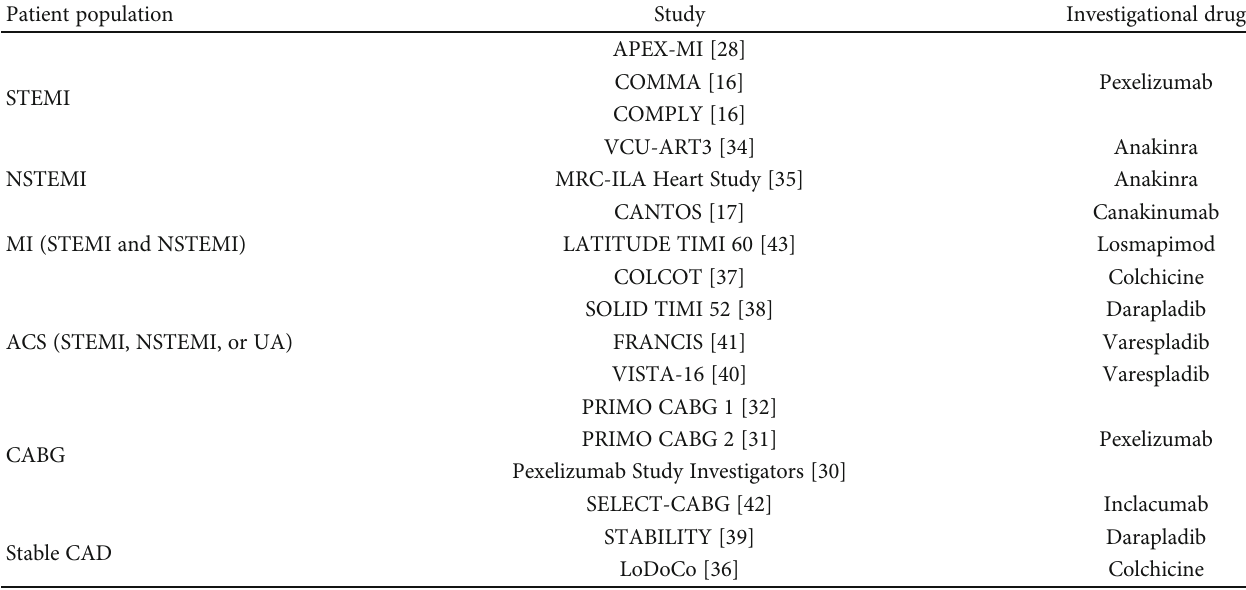
Table 2: Patient population and clinical scenario among included